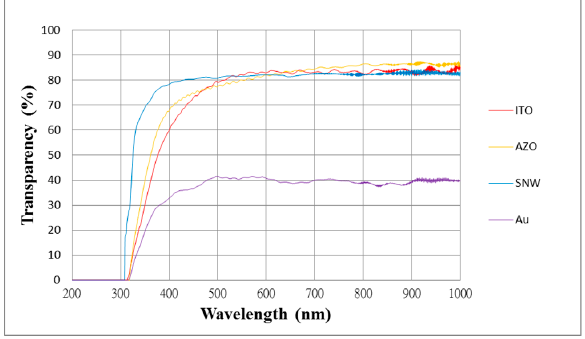
Figure 11. Transmittance measurements of CMUTs with gold, ITO, aluminum-doped zinc oxide (AZO), and silver nanowire top electrodes.